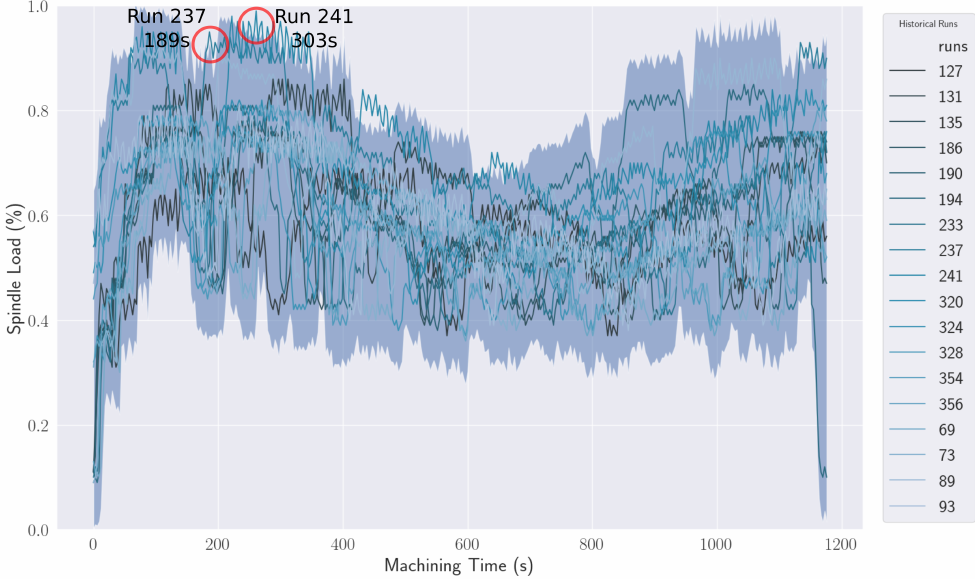
Figure 8. Normal behavior without run 237 and 241 and raw data on